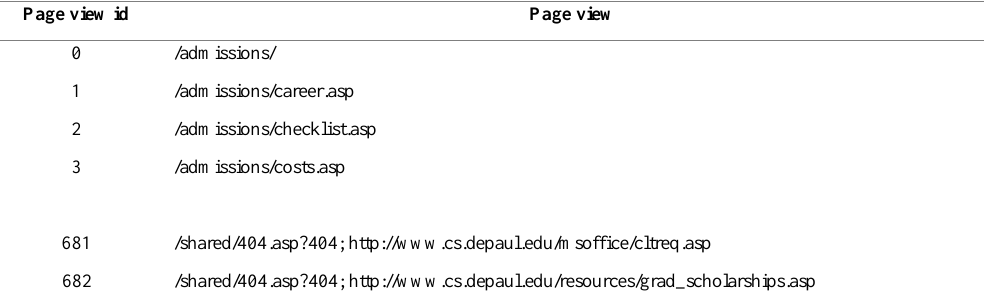
Table 4 . List of the page view IDs along with a page view in the CTI dataset.